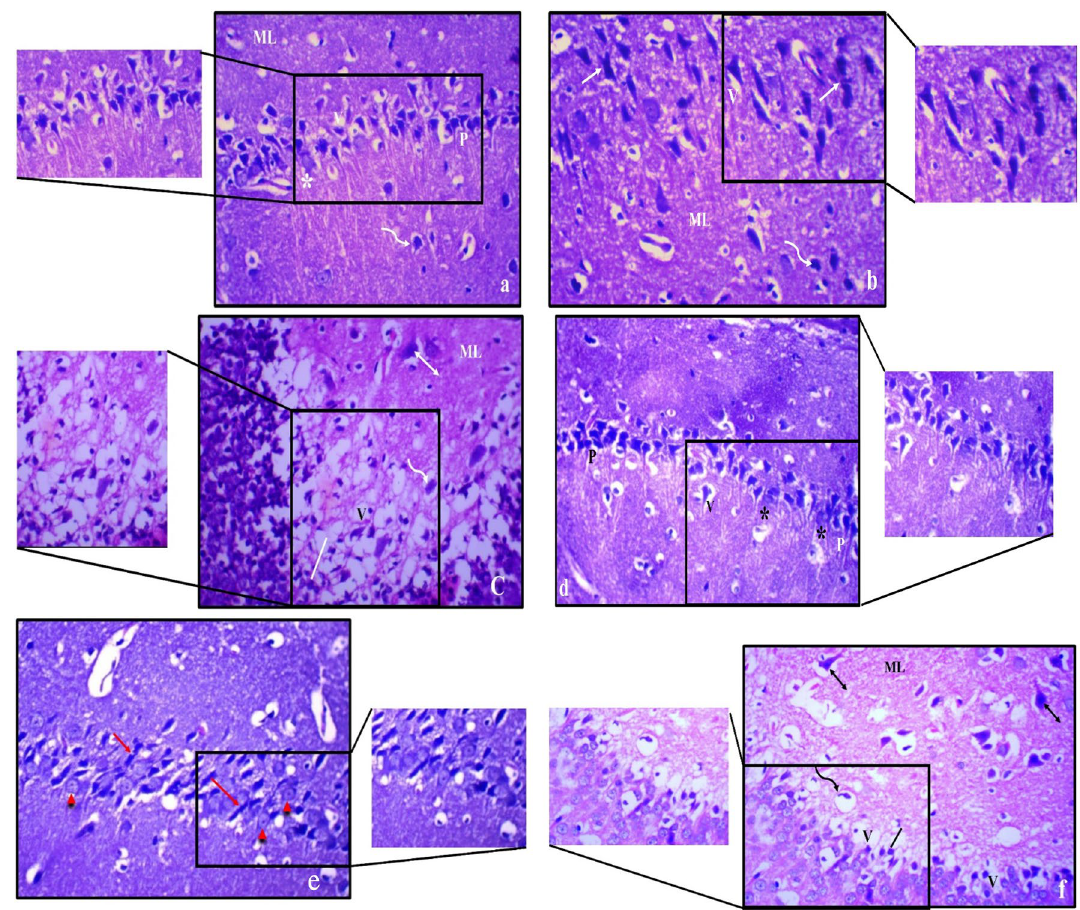
Figure 7. Photomicrograph of haematoxylin and eosin-stained sections from hippocampus of obese male rat ( a – c ) and obese female rat ( d – f ), where; ( a ) showing areas of small pyramidal neurons loss; some have pyknotic (P) and others have karyorrhectic ( * ) nuclei with vacuolation (V); ( b ) disorganization and extensive damage with apoptosis of most large pyramidal neurons ( ↑ ) with vacuolation (V); ( c ) granular cell layers (|) showed cell loss with marked vacuolations. Molecular layer (ML) shows marked enlargement of pyramidal ( ↕ ) and glial cells (wavy arrow); ( d ) showing areas of small pyramidal cells loss; some have pyknotic (P) and others have karyorrhectic ( * ) nuclei with vacuolation (V); ( e ) disorganization and extensive damage with apoptosis of many large pyramidal cells ( ↑ ) with few normal cells (right pointing triangle); ( f ) granular cell layers (|) showed cell loss with less vacuolation compared to males. Molecular layer (ML) shows marked enlargement of pyramidal ( ↕ ) and glial cells (wavy arrow) (H & E,